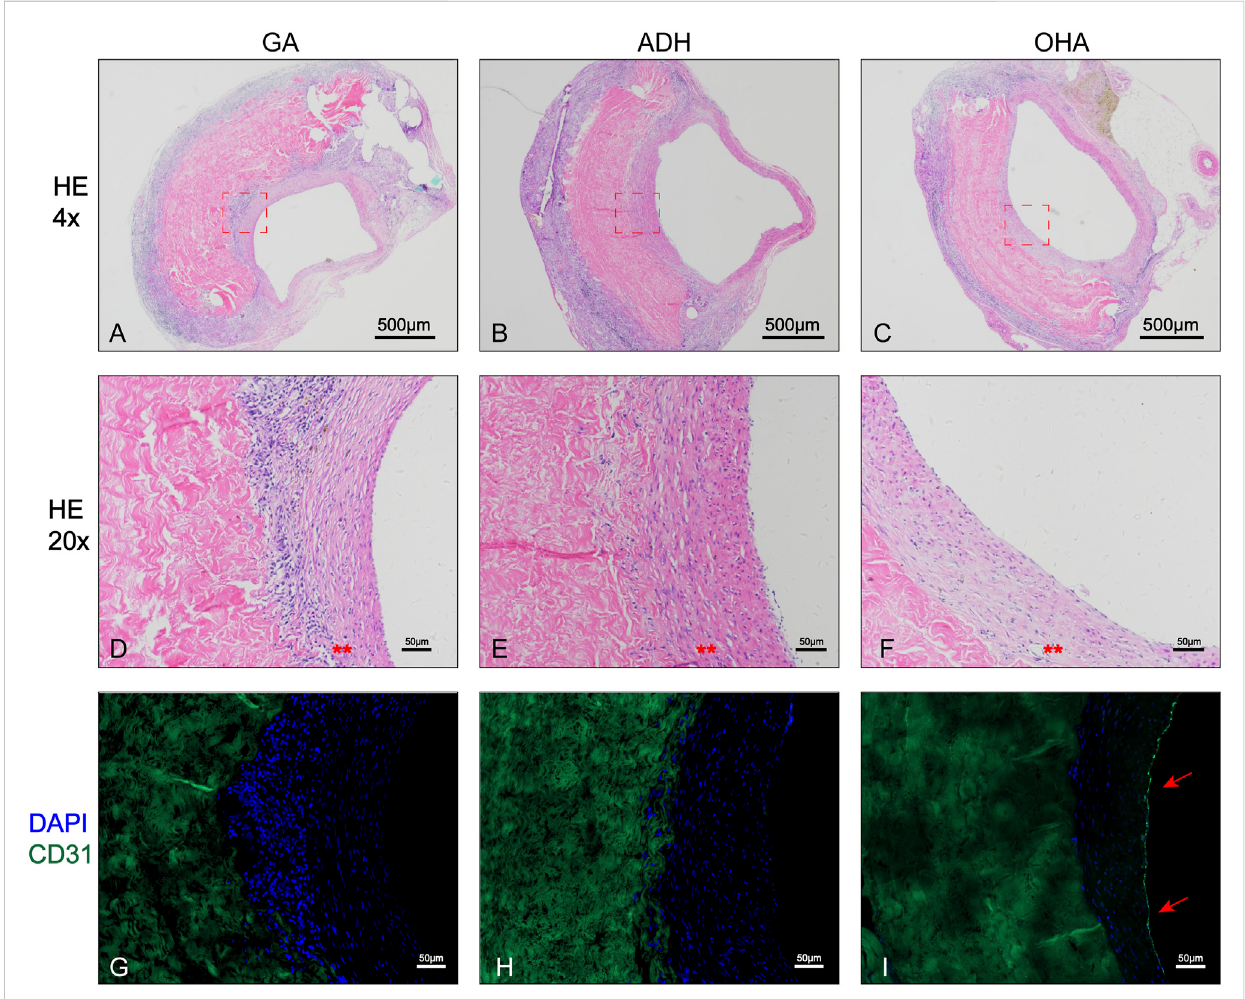
FIGURE 7 Histological analysis of the rat infrarenal abdominal aorta patch repair model. Images show the 4x (A – C) and 20x (D – F) results of HE staining in the threegroups,andtypicalcobblestone-likecellscouldbeobservedintheOHAgroup.Immuno fl uorescencestainingfortheendothelialcellmarkerCD31 (G – I) showed complete CD31 + cell coverage in the OHA